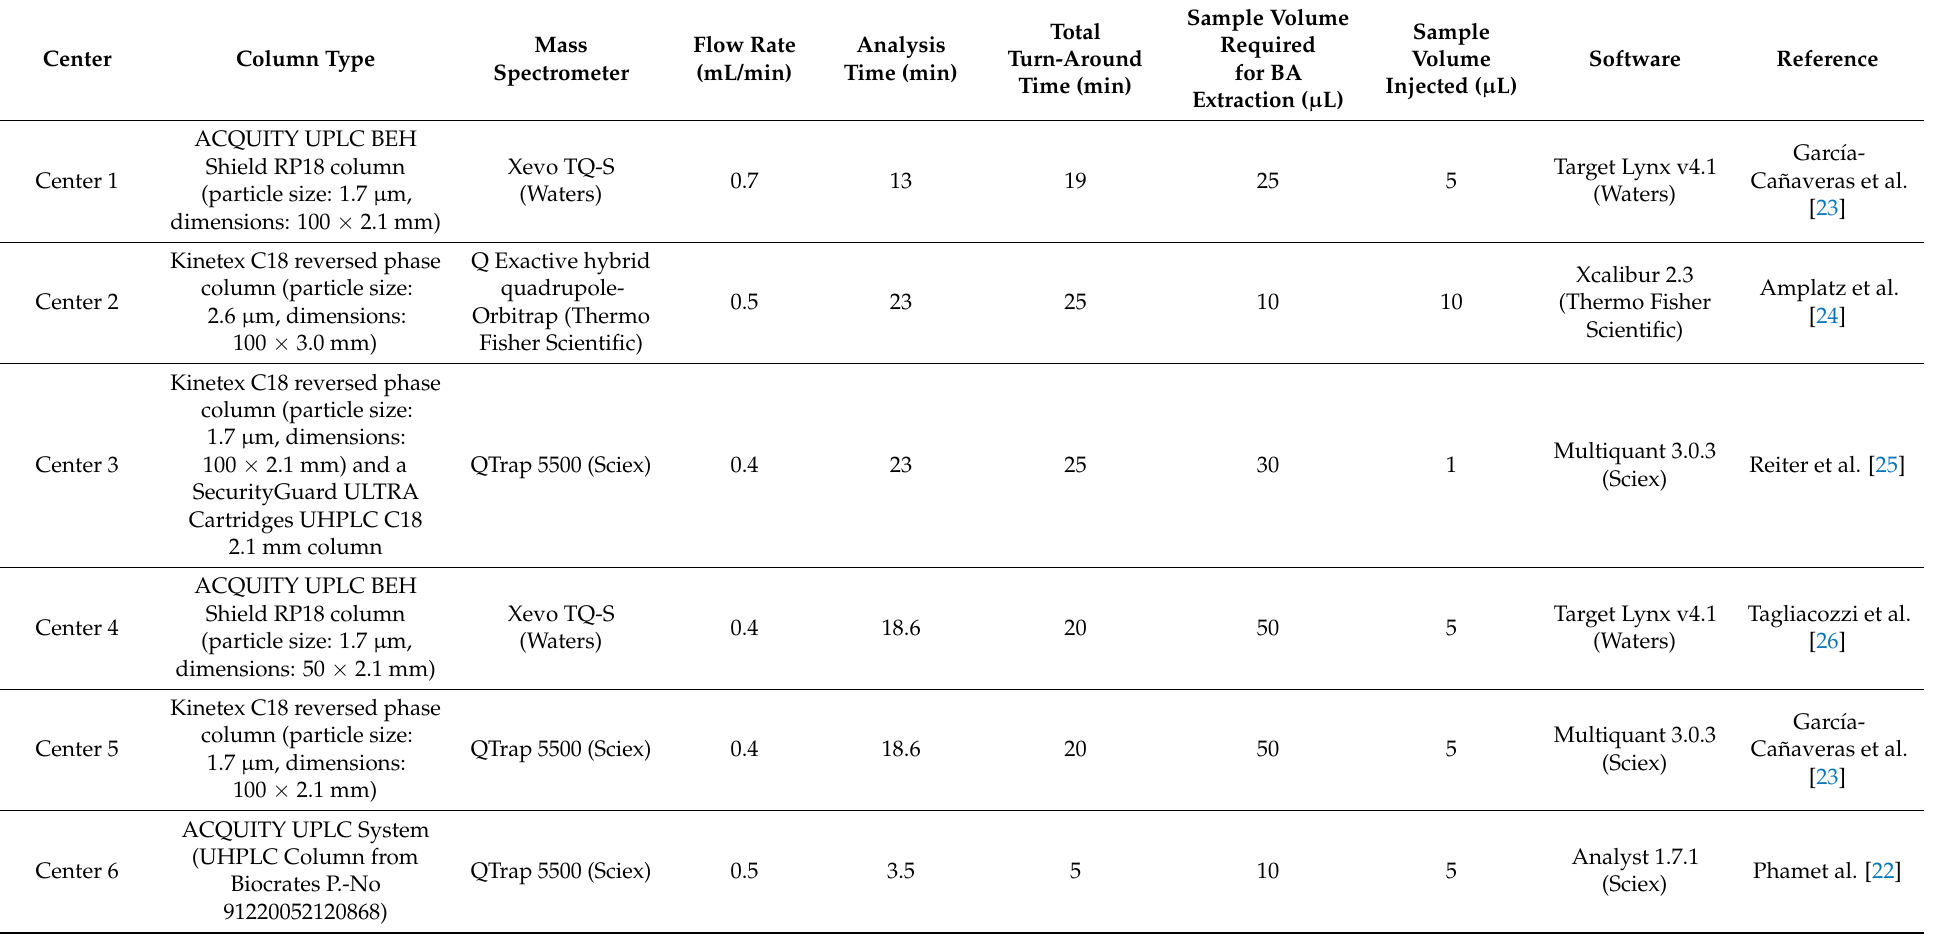
Table 4. Summary of the methodology used by the individual